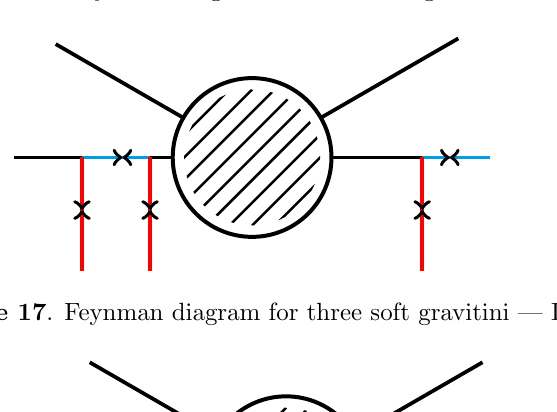
Figure 16 . Feynman diagram for three soft gravitini | I.